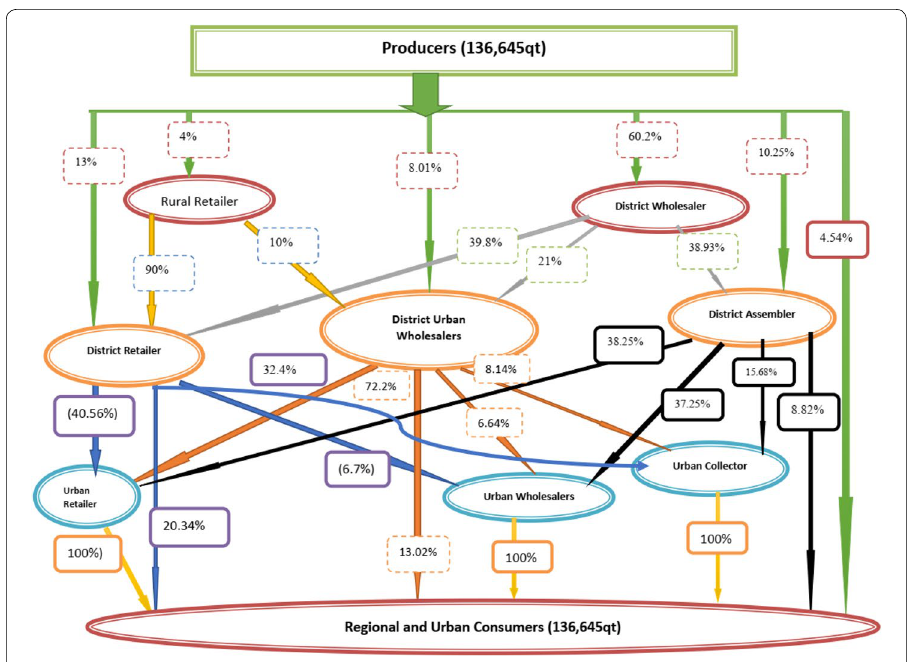
Fig. 2 Market channels of red